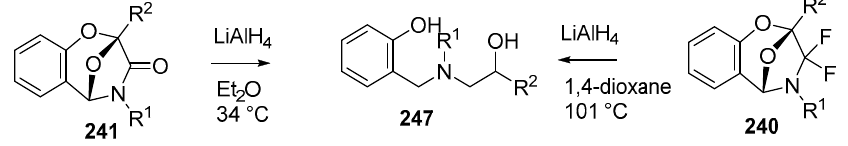
Scheme 72. Reduction of cycloadducts 240 and 241 . Table 34. Reduction of cycloadducts 241 and 240 with LiAlH 4 (Scheme 72).